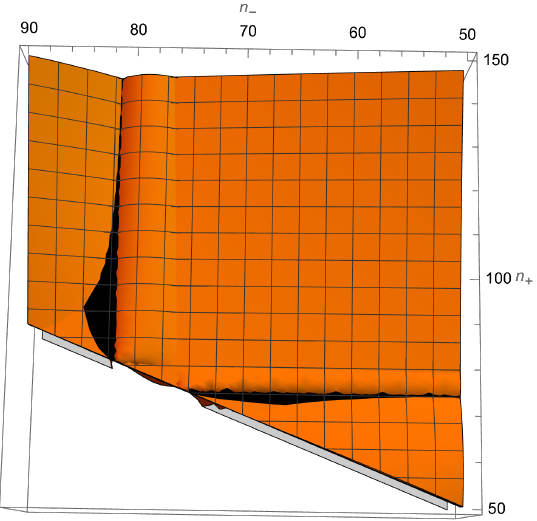
Figure 2 . We plot the domain of validity for the magnetic charges { p 1 , p 2 , p 3 , p 4 } = {− 87 + n + + n − , 5 , 11 , 71 } for regime 1 of class 2 twist solutions. The plot black islands are areas in ( n + , n − ) parameter space where the order of the roots has been enforced. Imposing in addition the positivity of the scalars lifts these regions leaving just orange regions and no solution. This type of behaviour is common to both regime 1 and regime 2 and therefore we shall ignore them in the